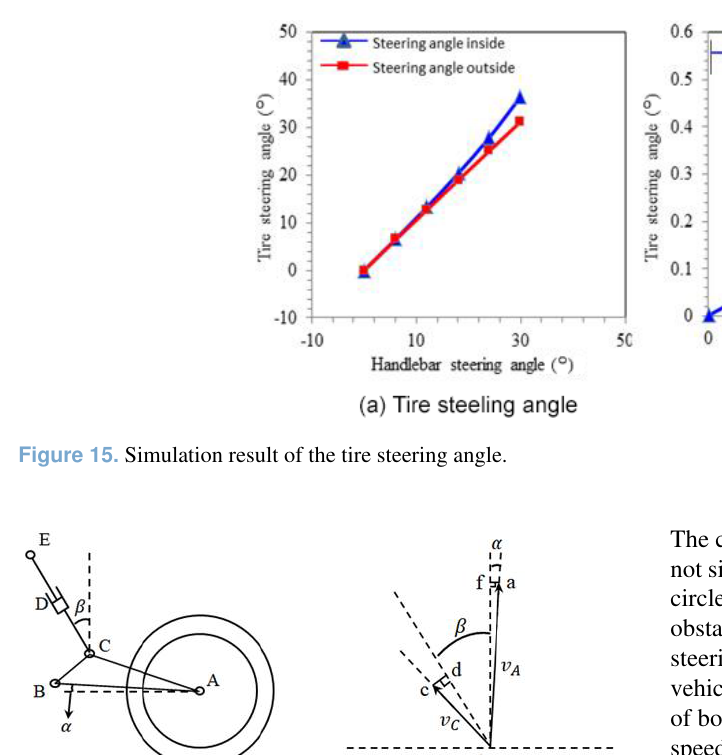
Figure 14. Simulation result of the tire steering angle.